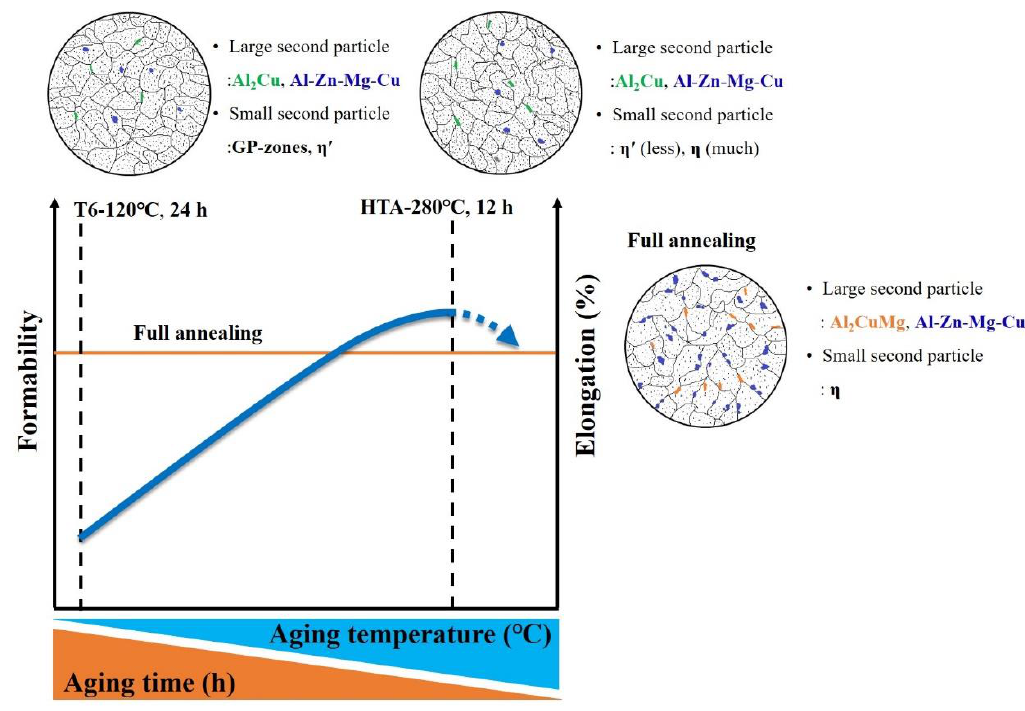
Figure 14. A schematic diagram of the relationships among formability, elongation, and microstructure for 7075 aluminum alloy after various